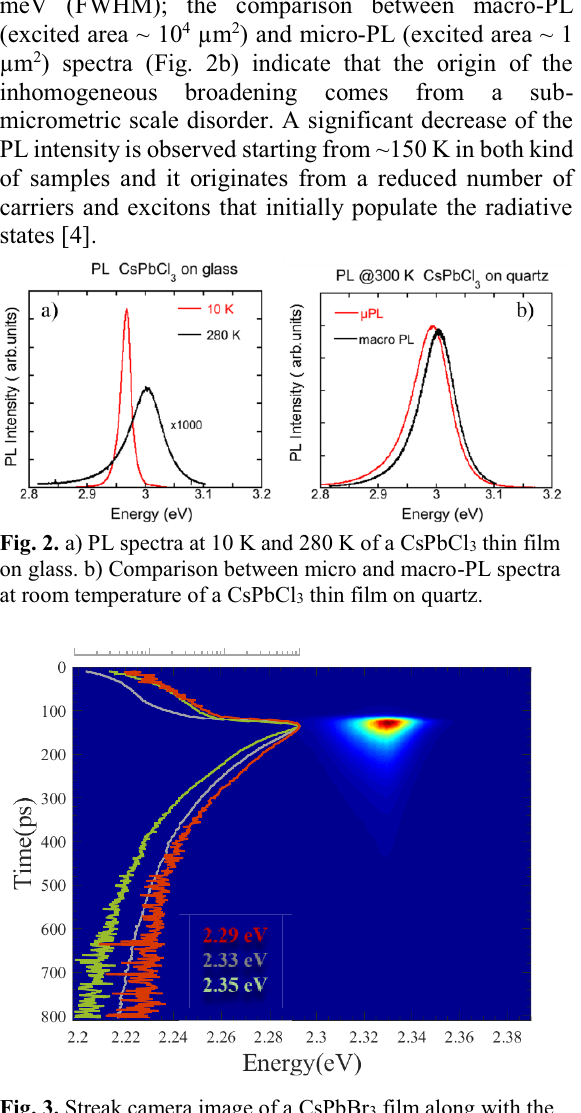
Fig. 3. Streak camera image of a CsPbBr 3 film along with the normalized PL decays (Log scale) extracted from the image at three different energies: 2.35 eV free carrier recombination, 2.33 eV localized exciton emission, and 2.29 eV low energy side due to deeper exciton